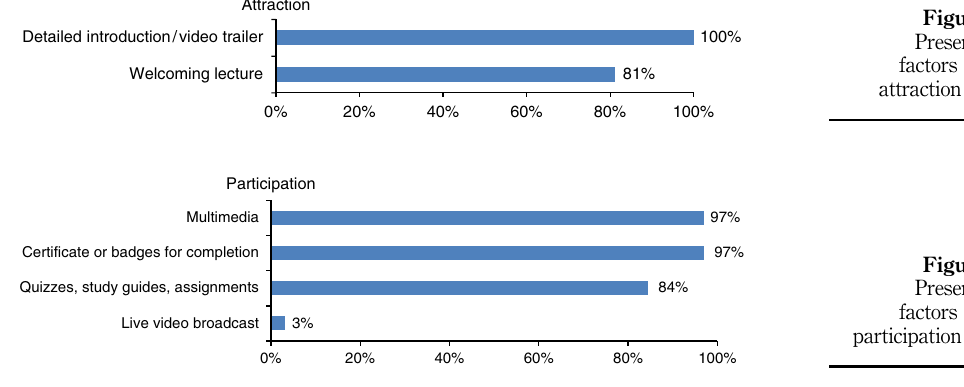
Figure 1. Presence of factors in the attraction stage